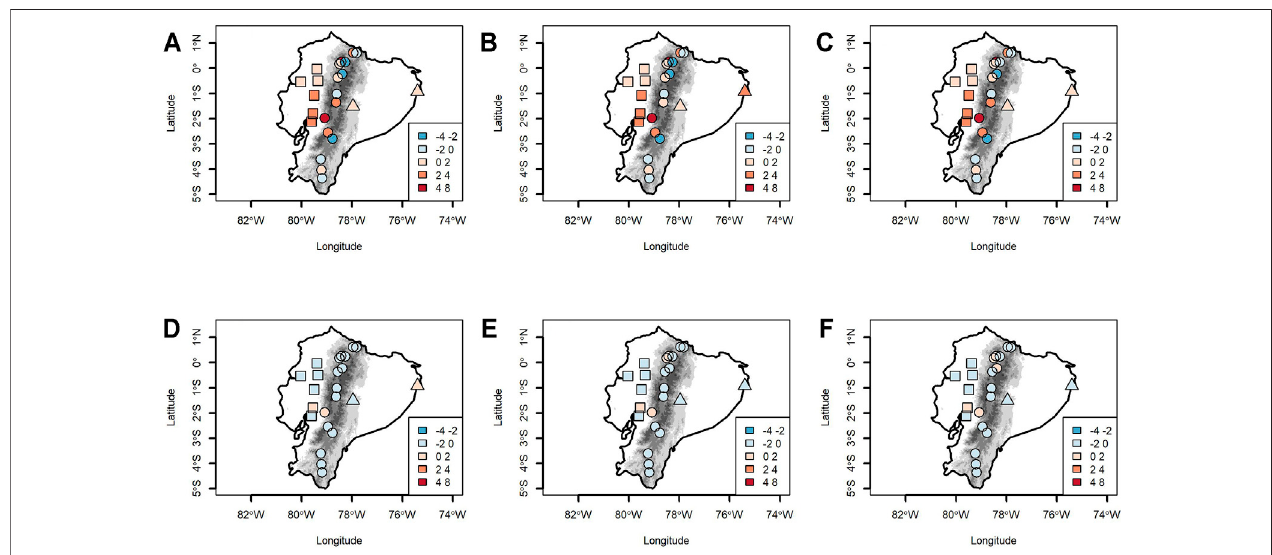
FIGURE 2 | Differences between simulated and observed P84Tmax values. In columns are the models CSIRO, GISS, and IPSL. In the rows; without correction models (A – C) and corrected models through PTF method (D – F) .